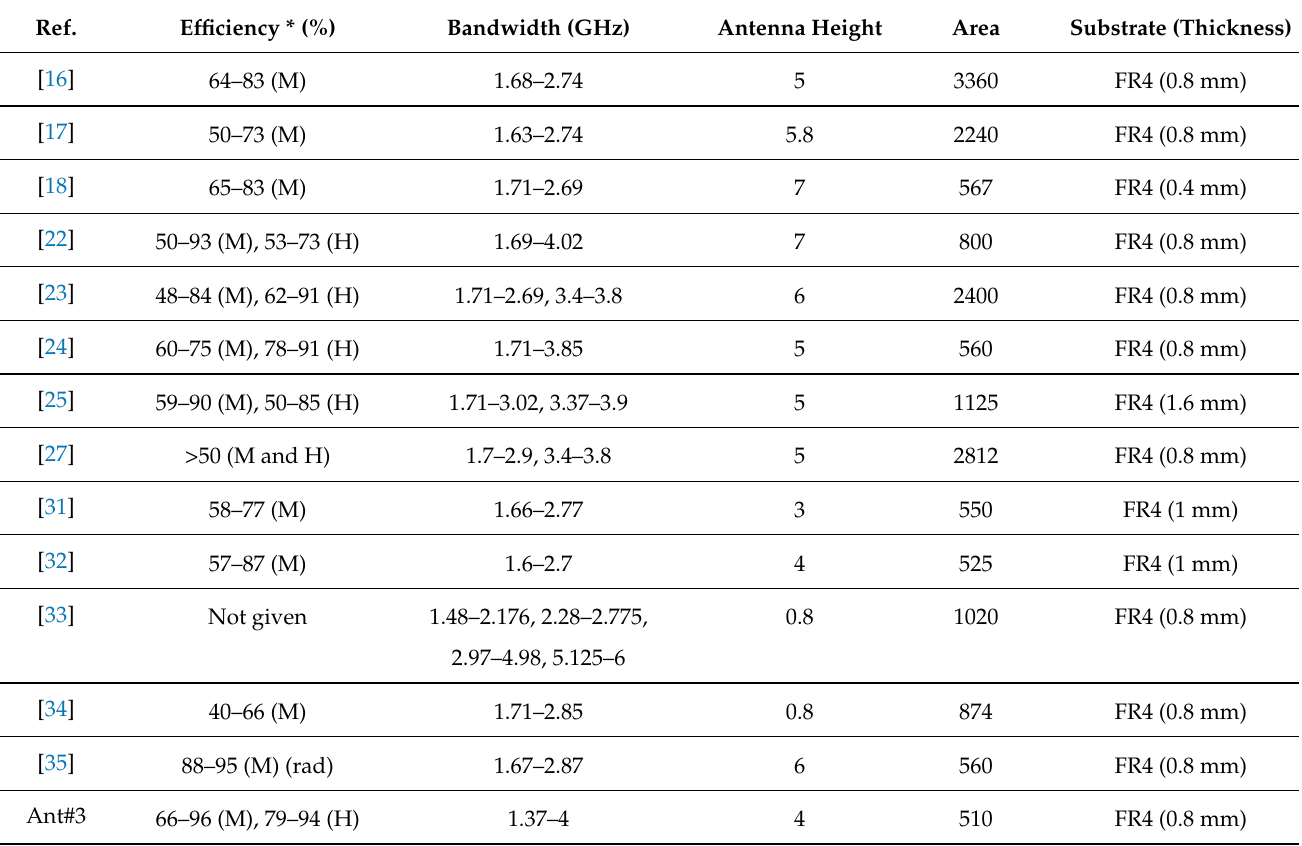
Table 4. Performance comparison of the reference antennas and the proposed wideband antenna for the LTE mid and high